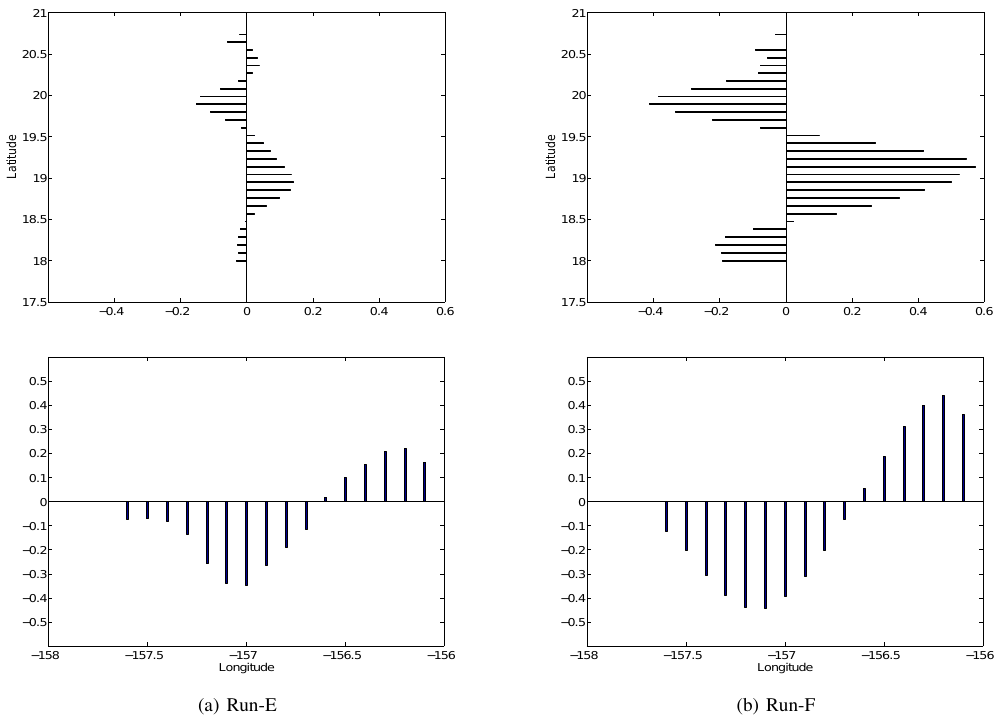
Fig. 12. East-west horizontal velocity [m s − 1 ] component at 40-m depth vector across a north-south transect (top) and north-south horizontal velocity component across a east-west transect (bottom) of the eddy C5-E (Run-E, April 13, left) and of the eddy C1-F (Run-F, March 28, right).